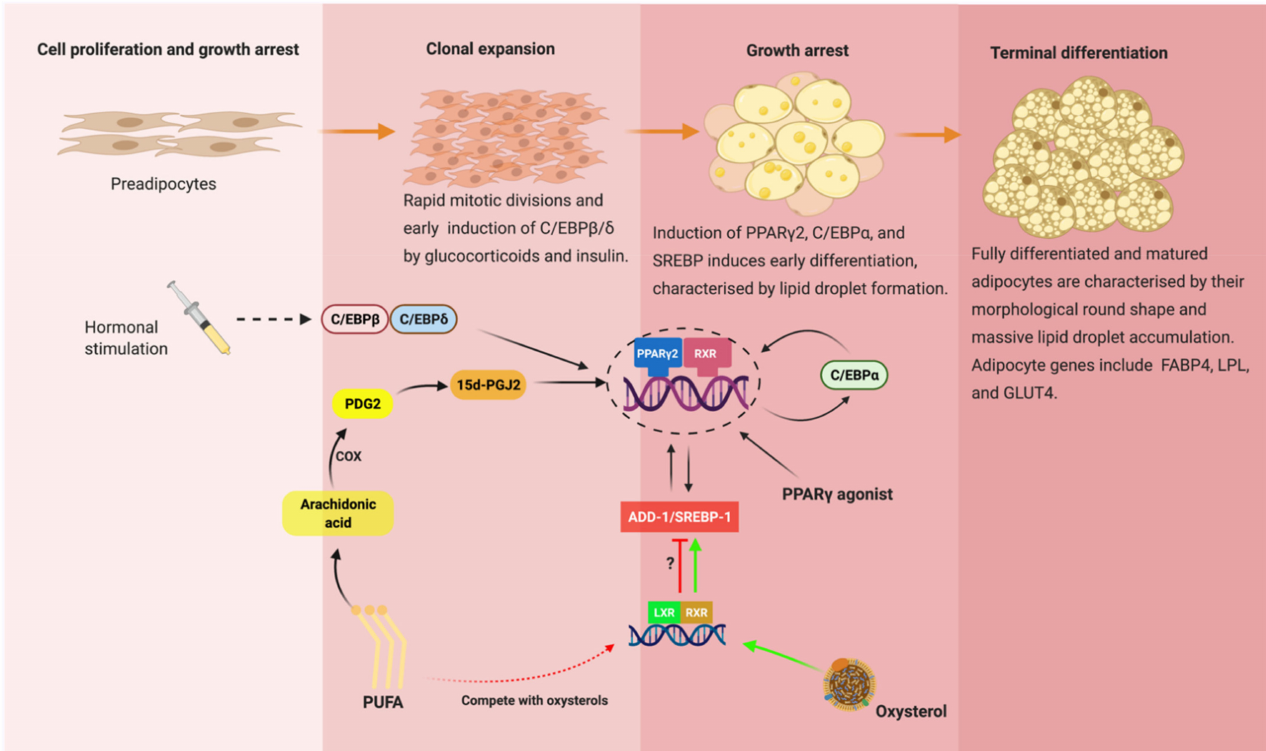
Figure 2. Transcriptional regulation of adipogenesis: Effective adipogenesis depends on the interdependency of several transcription factors. The treatment of preadipocytes with hormonal stimulants, such as glucocorticoids, cAMP, and insulin, transiently induces C/EBP β and δ early in adipogenesis. Together, C/EBP β and δ induce PPAR γ 2. C/EBP α , another member of the C/EBP family of transcription factors, is induced later on during adipogenesis by PPAR γ 2, and in turn, C/EBP α sustains the high levels of PPAR γ 2. The expression of ADD-1/SREBP-1, which PPAR γ 2 enhances, is necessary to induce target genes involved in the fatty acid synthesis, leading to the accumulation of lipid droplets, a characteristic of fully matured adipocytes. PUFA control adipogenesis via its endogenous derivative 15d-PGJ2. PUFA may also impair the induction of SREBP1 by competing with oxysterols, a potent LXR ligand. Abbreviations: ADD-1: adipocyte differentiation and determinant factor, C/EBP: CCAAT enhancer-binding protein, cAMP: cyclic AMP, PUFA: polyunsaturated fatty acid, PPAR: peroxisome proliferator-activated receptor, PDG2: prostaglandin G2, SREBP-1: sterol regulatory element-binding protein 1, 15d-PGJ2:15-deoxy- ∆ 12,14-prostaglandin J2. Created with BioRender.com, accessed on 16 March